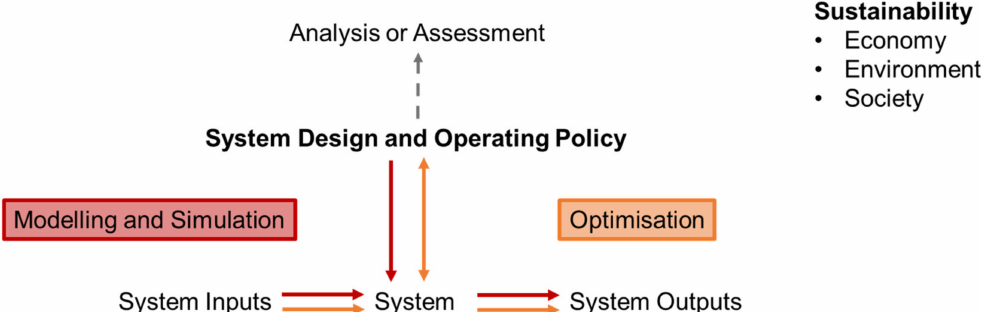
Figure 4. The research direction of sustainable system design. Modified based on Loucks [40]. The considered tools reviewed in this study include those used for modelling and simulation, optimisation, and analysis or assessment, that can contribute to energy system design. Red arrows represent modelling and simulation. Orange arrows represent optimisation. The grey arrow represents analysis or assessment. For example, modelling and simulation utilise system inputs and the available system design and operating policy to identify the system outputs. Analysis or assessment is conducted to determine the performance of an existing